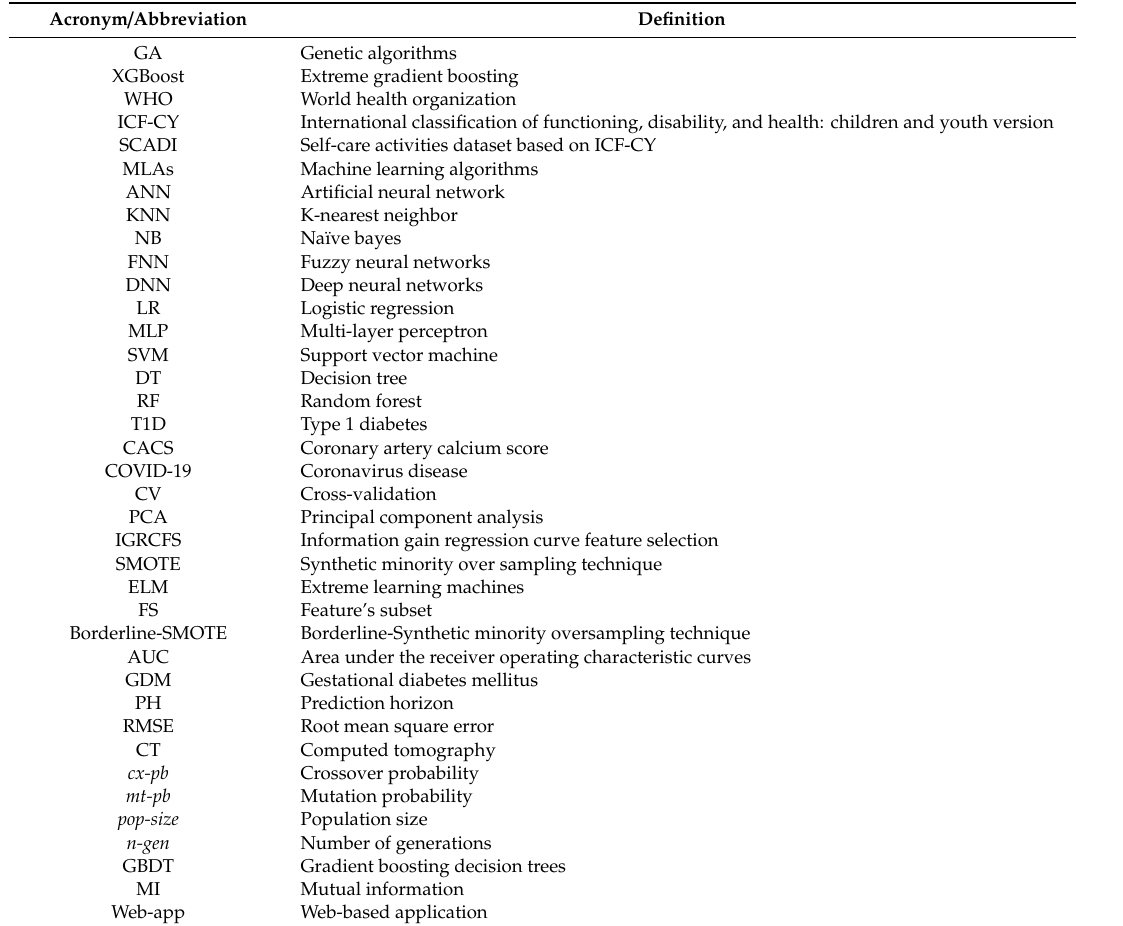
Table A1. List of acronyms and / or abbreviations used in the